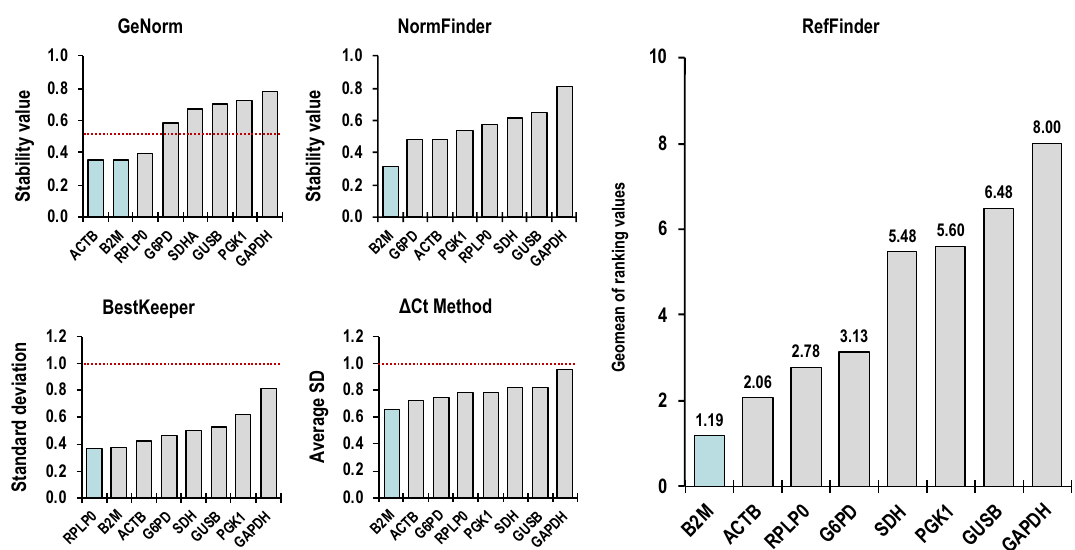
0.00.20.40.60.81.0